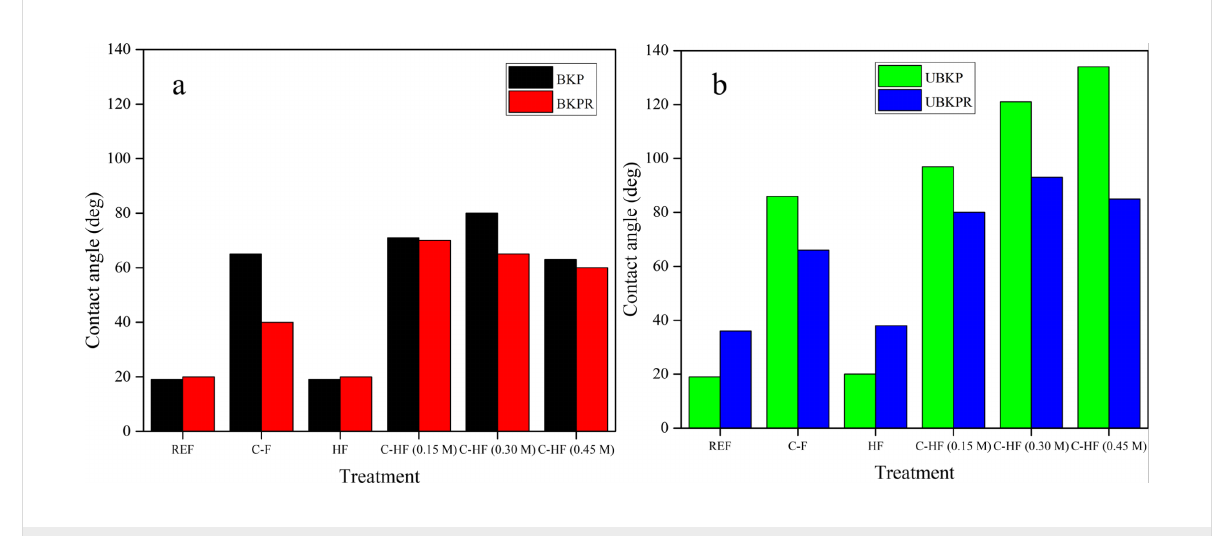
Figure 9: Water contact angle for (a) BKP and BKPR, (b) UBKP and